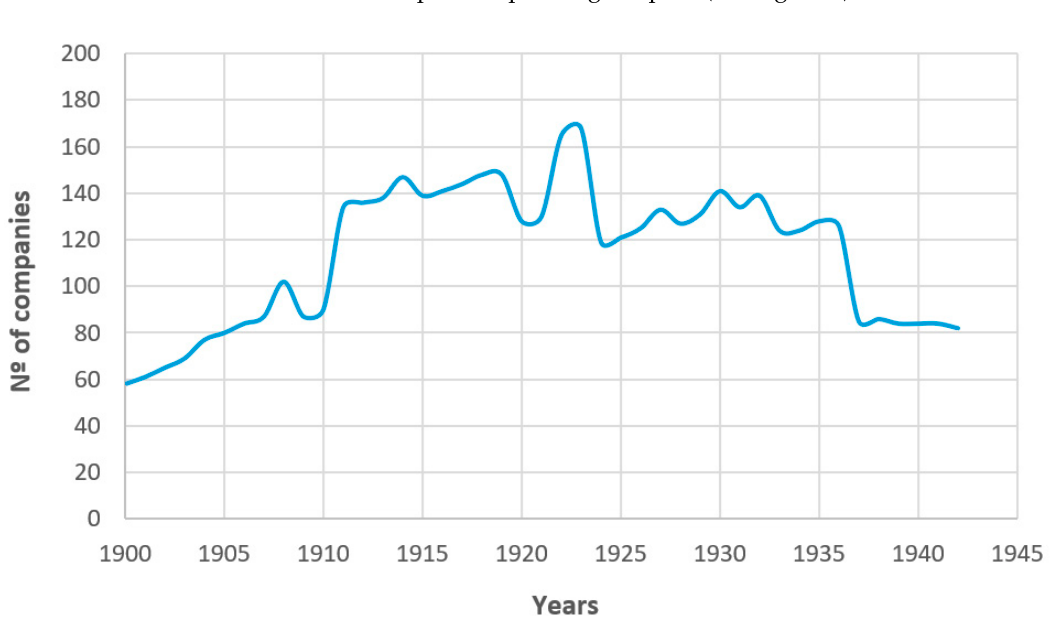
Figure 5. Evolution of the number of water companies from 1900 to 1942.